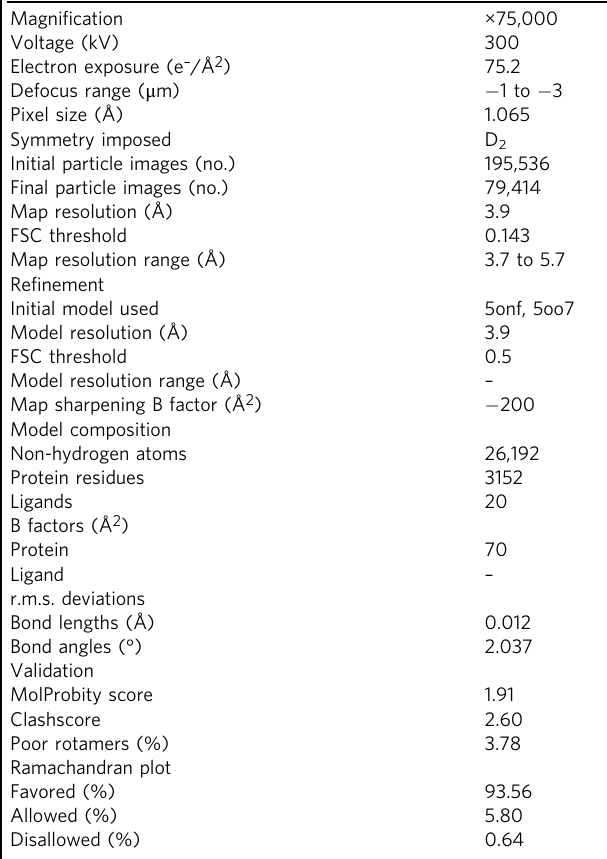
Table 2 Cryo-EM data collection, re fi nement, and validation statistics of the AENTH 16-mer